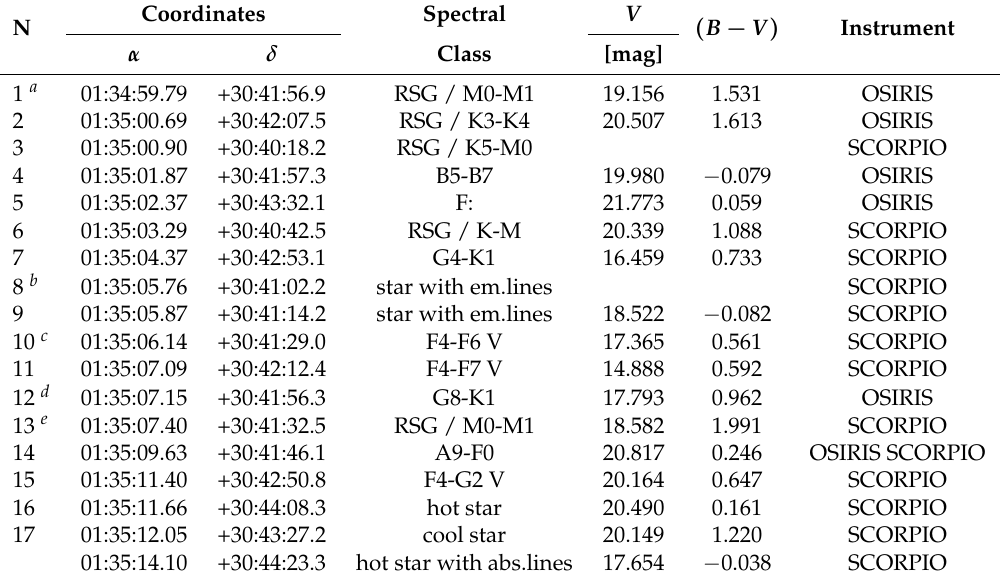
Table 2. The sample of stars in the field around GR290 studied in this work. N corresponds to the labels in Figure 1. V and ( B − V ) taken from Massey et al.